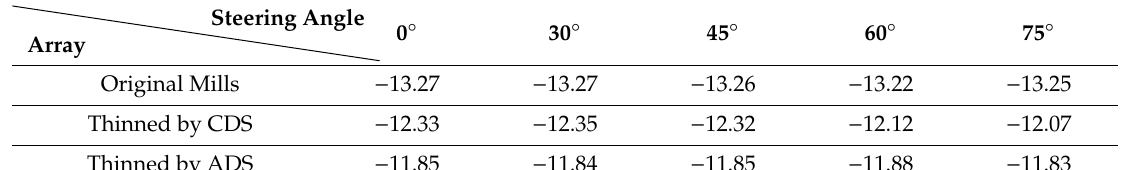
Table 2. PSLL values of the beam patterns for three arrays at various steering angles.